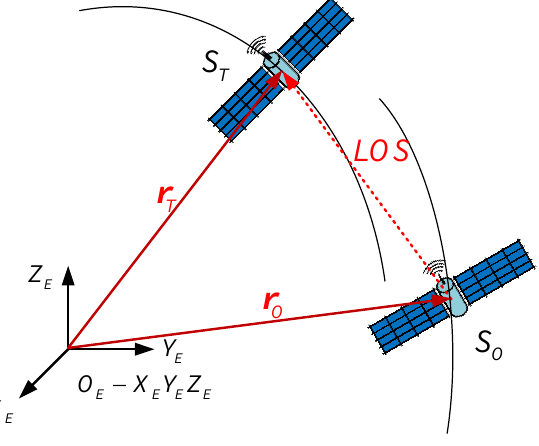
Figure 1. Orbits and inertial LOS Measurement.